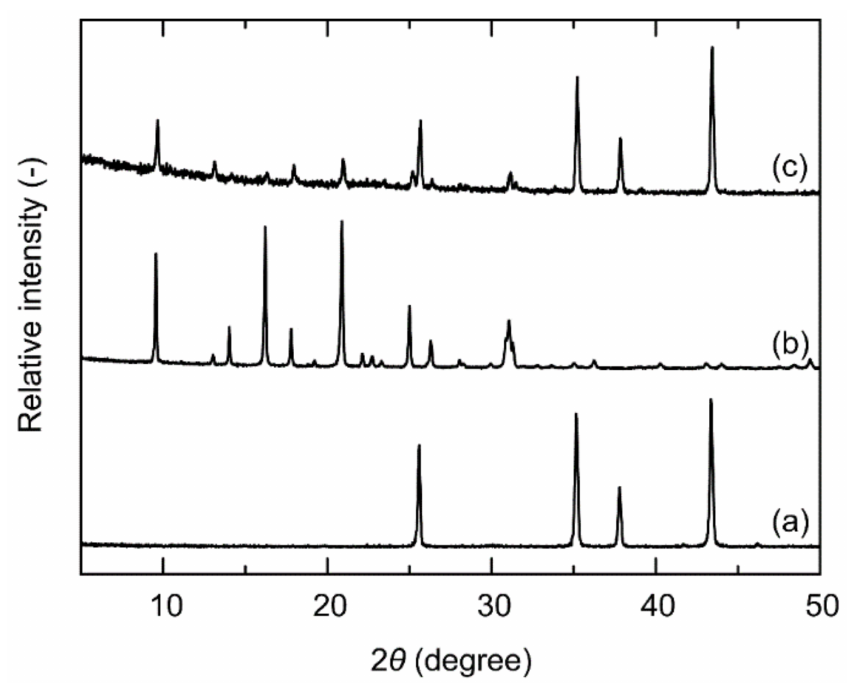
Figure 3. XRD patterns of ( a ) support tube, ( b ) seed particles, and ( c ) membrane.